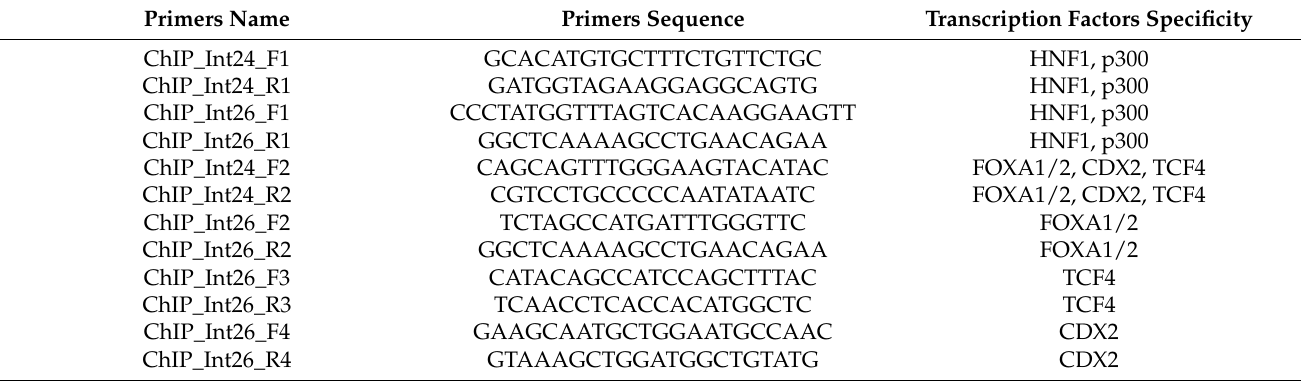
Table A3. Primers used to analyse immunoprecipitation in Caco-2